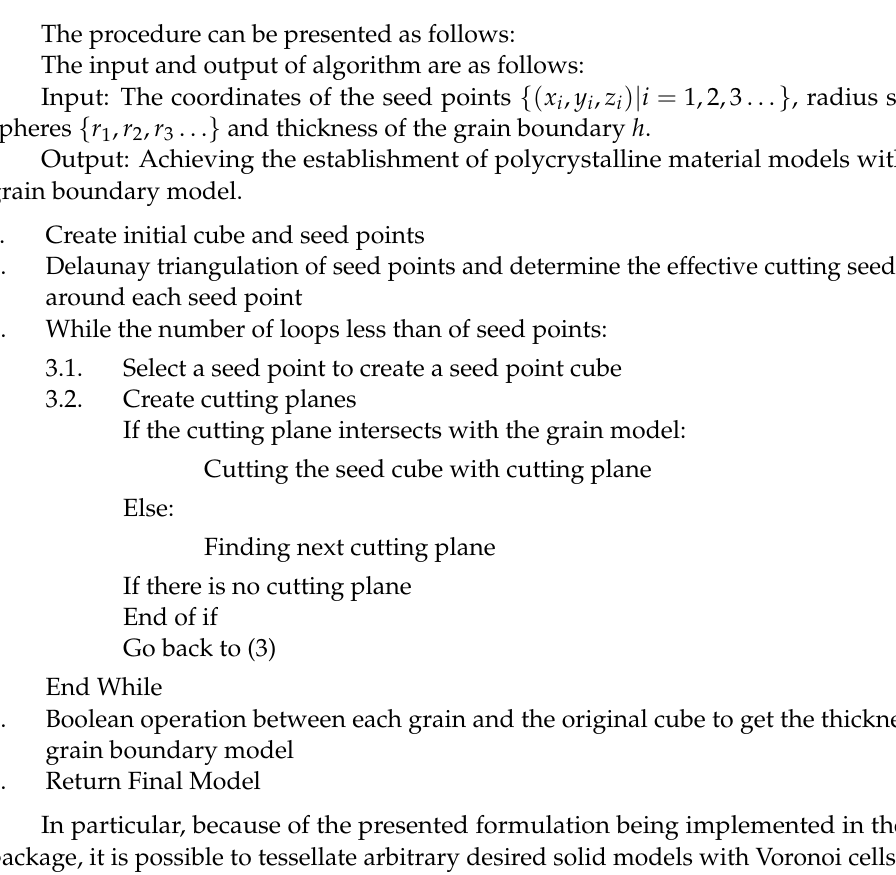
Figure 4. The polycrystalline microstructure model with grain boundary thickness h